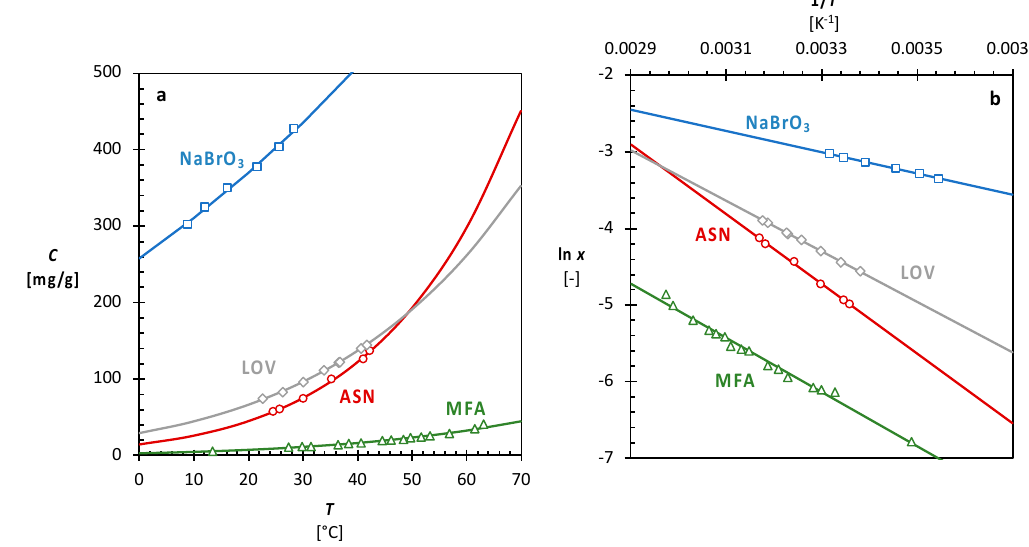
Figure 3. ( a ): temperature dependent solubilities of NaBrO 3 in water (blue, ■ ), ASN in water (red, ● ), MFA in ethanol (green, ▲ ), and LOV in acetone (grey, ♦ ). ( b ): The same data with the fits to Equation (2). The lines through the points in both graphs are best fits to Equation (2).